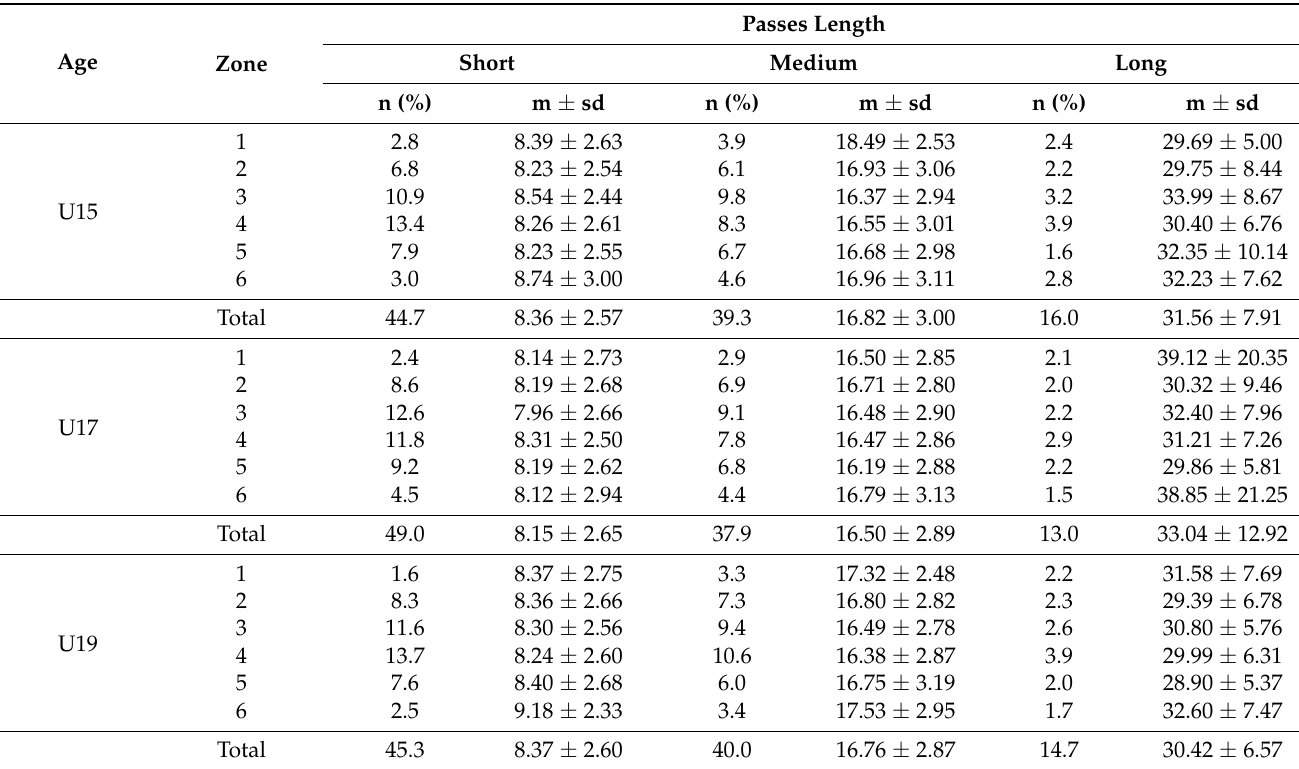
(Table 1).Pairwise comparison revealed that U15 used more long passes than U17 and U19. Table 1. Descriptive analysis of passes length by